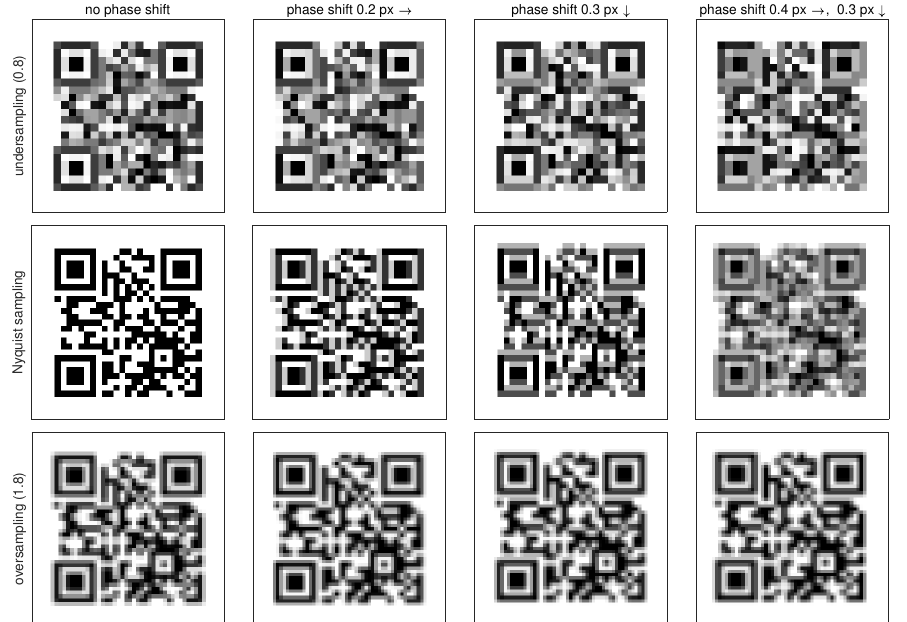
Figure 4. Sampling QR code near the Nyquist limit.